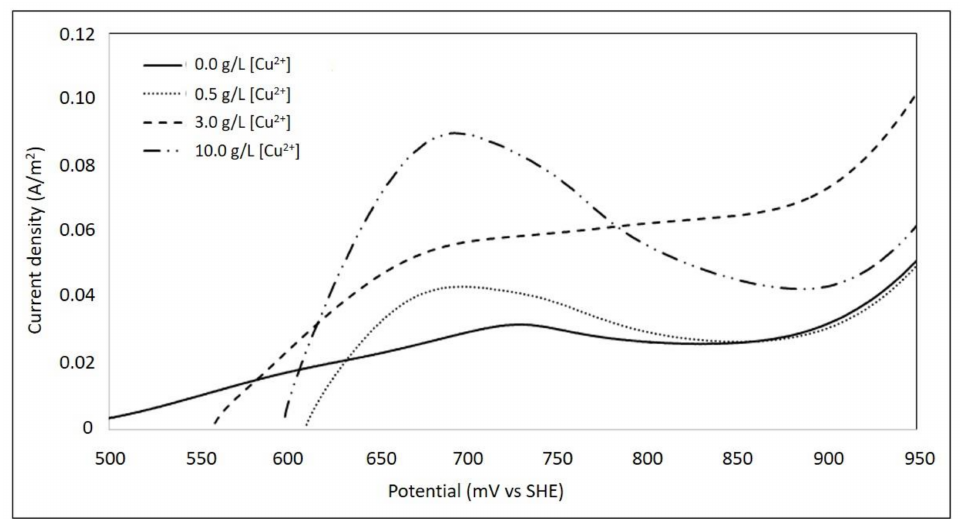
Figure 8. Effect of the concentration of cupric ions at 0, 0.5, 3.0, and 10.0 g/L on the chalcopyrite electrode (1 mV/s) using a solution with 20 g/L [Cl − ], 1 g/L [Fe 2+ ], and pH 1 adjusted with sulphuric acid at 25 ◦